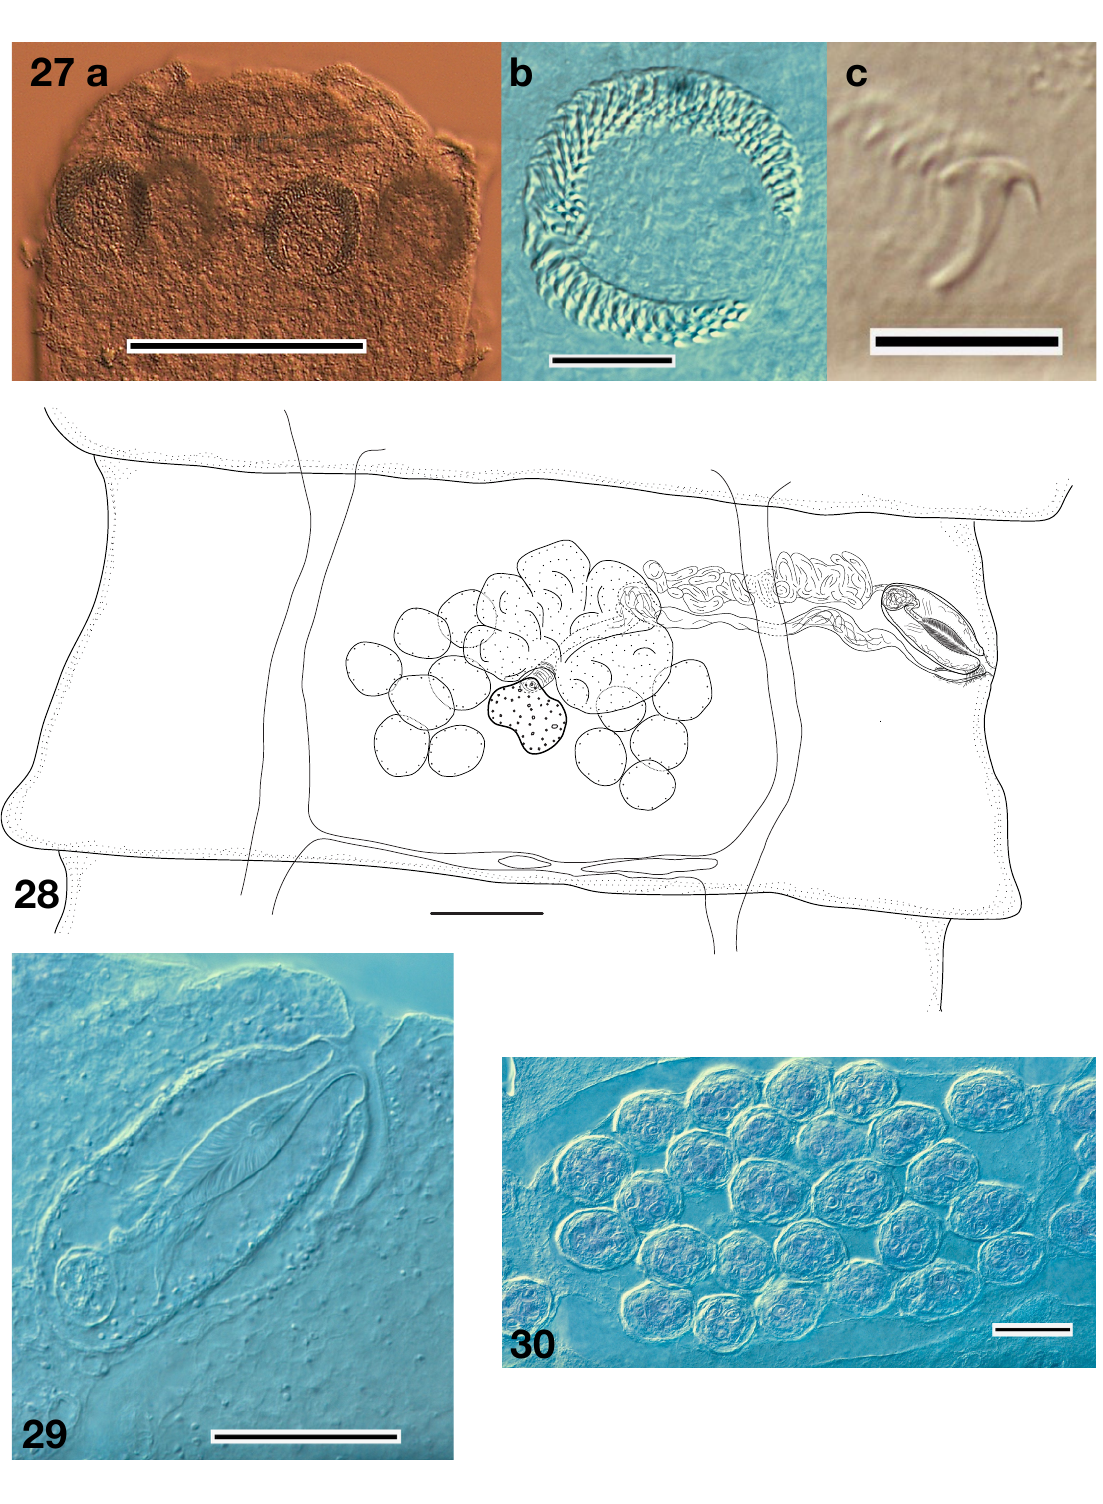
Figs 27-30. Raillietina mahnerti sp. nov. 27 . a) Scolex, b) Sucker's hooklets, c) Rostellar hook; 28 . Mature proglottis, ventral view; 29 . Copulatory organs; 30 . Gravid proglottis with egg capsules. Figs 27–30. Raillietina mahnerti sp. nov. 27 . a) Scolex. b) Sucker hooklets. c) Rostellar hook. 28 . Mature Scale bars: 27a, 28, 30 = 100µm; 27b = 20 µm; 27c = 10 µm; 29 = 50µm. proglottis, ventral view. 29 . Copulatory organs. 30 . Gravid proglottis with egg capsules. Scale bars: 27a, 28, 30 = 100 µm; 27b = 20 µm; 27c = 10 µm; 29 = 50